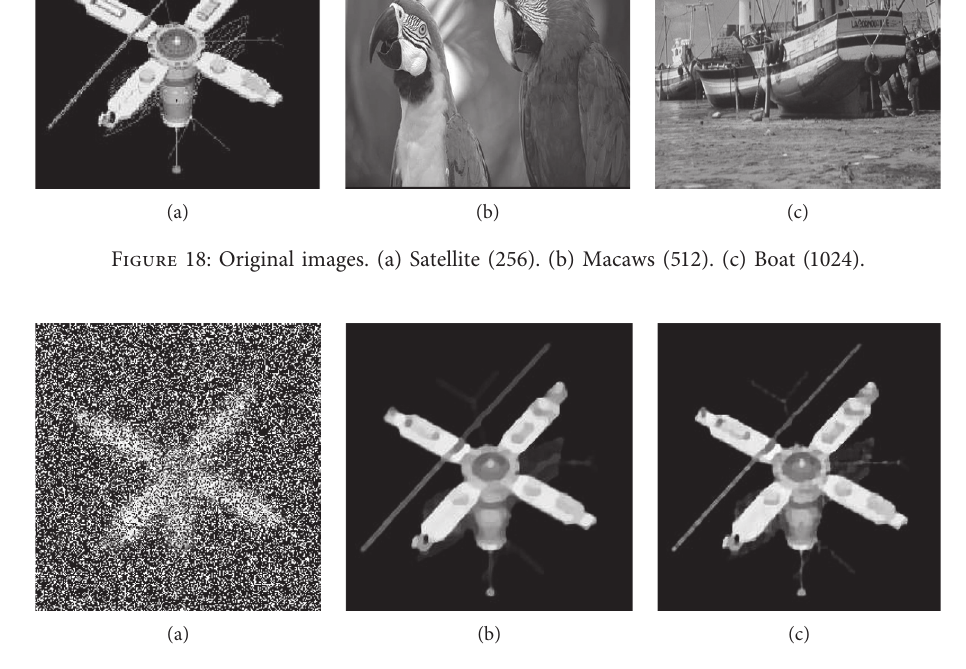
Figure 19: The recovery results (satellite 256 × 256) by Average blur with 60% SP noise. (a) Average blur (lev � 0.6). (b) L0TV, PSNR � 24.4399. (c) LogTVSCAD, PSNR � 25.5613.